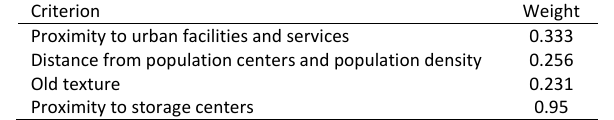
Table 3: Weights of urban elements and services Criteria for site selection of fire stations in District 12 of Tehran Based on AHP method